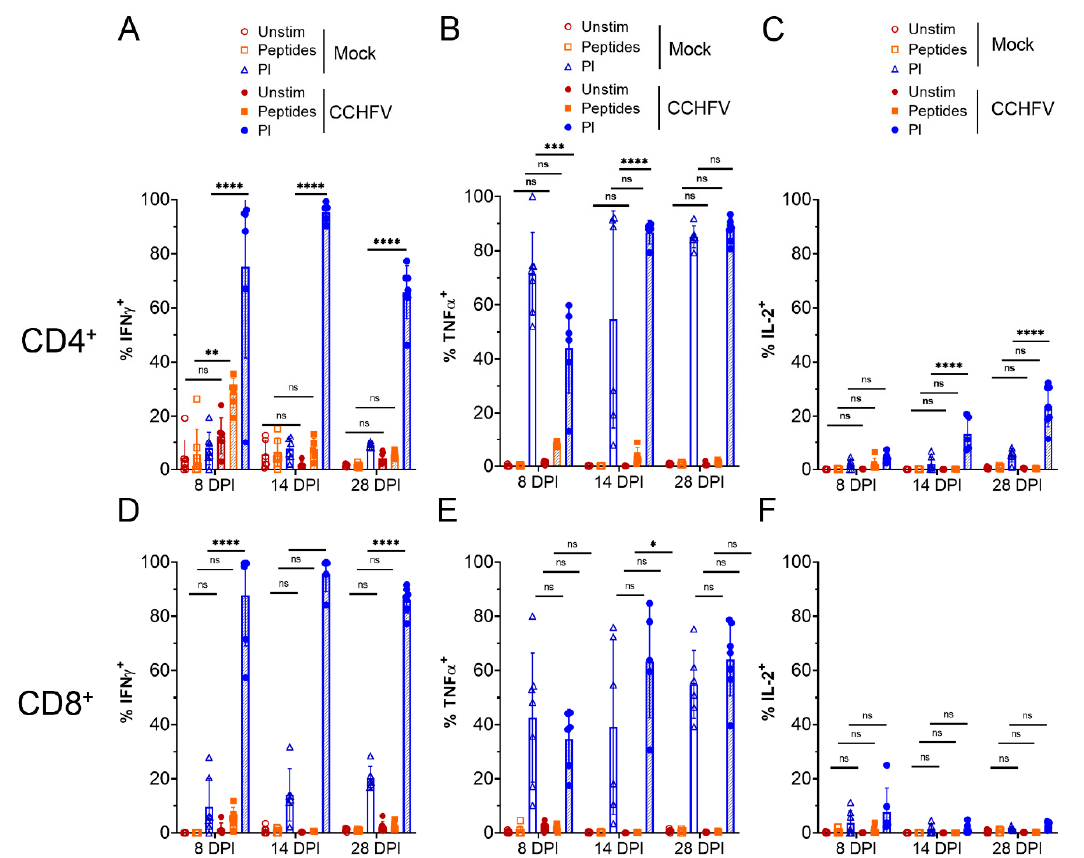
Figure 2. T-cells produce Th-1 cytokines in response to infection. IFNAR − / − mice were infected with CCHFV or mock- infected. At indicated time points mice were euthanized, single cell suspensions generated from the liver and cytokine production by CD4 + T-cells ( A – C ) or CD8 + T-cells ( D – F ) measured by ICS and flow cytometry after ex vivo stimulation. CD4 + or CD8 + T-cells were identified as CD3+ and by exclusive expression of CD4 or CD8. Unstim = unstimulated. Peptides = peptide pool derived from the CCHFV NP. PI = PMA/Ionomycin. Data is presented as percentage of cytokine positive cells of parental CD4 + T-cells ( A – C ) or CD8 + T-cells ( D – F ). ( A – F ) N = 5–7 per group. Error bars indicate standard deviation. Statistical test comparing treatment groups between mock- and CCHFV-infected groups performed using two-way ANOVA with Tukey’s multiple comparison test. ns p > 0.05, * p < 0.05, ** p < 0.01, *** p < 0.001 **** p < 0.0001.